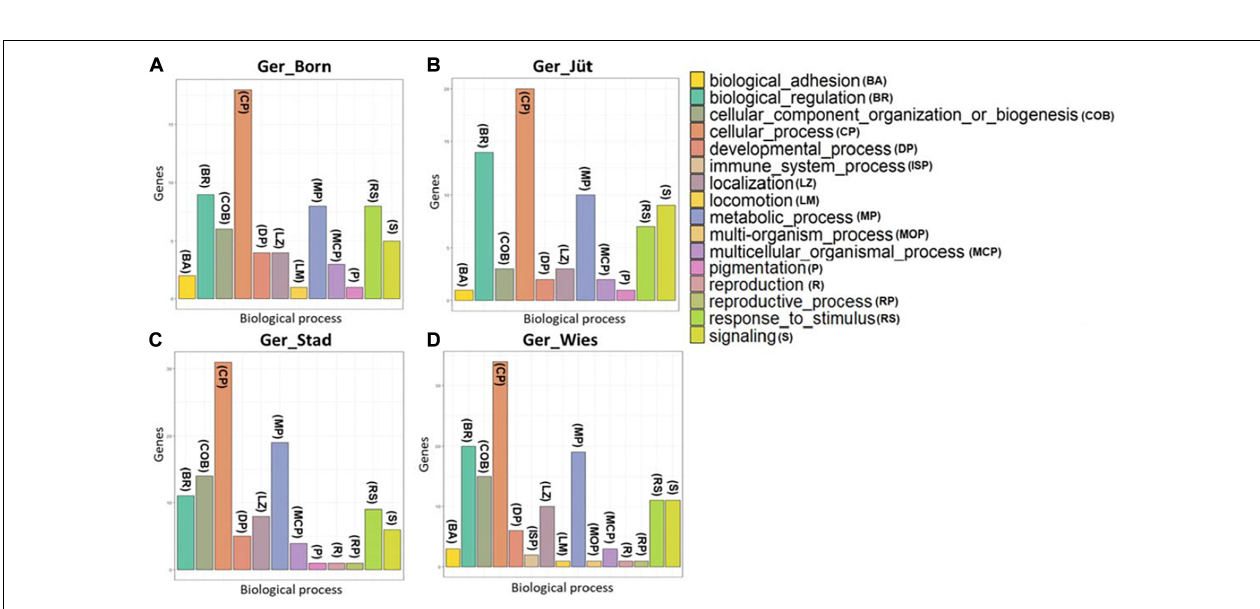
FIGURE 10 | Classification of genes with hotspot SNPs in ROH genome regions. Populations are presented as (A) Mecklenburg-Western Pomerania (Ger_Born), (B) Brandenburg (Ger_Jüt), (C) Lower Saxony (Ger_Stad), (D) Saxony (Ger_Wies). Abbreviations and sample numbers are specified in Figure 3 .